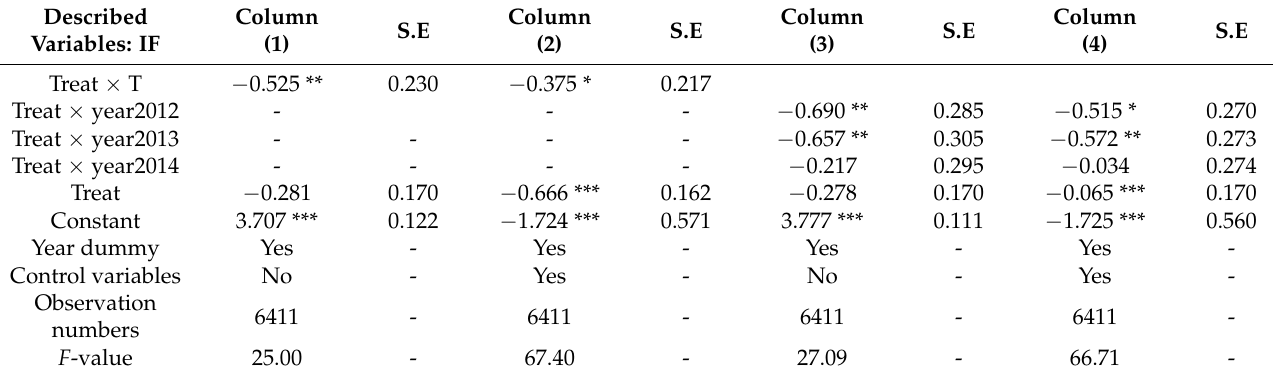
Table 4. Influences of mobile phone promotion policy on IF usage DID